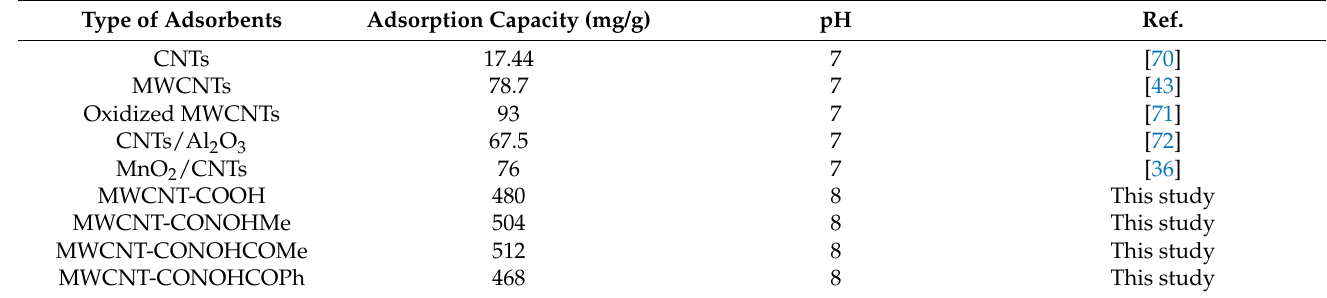
Table 7. Some CNT adsorbent capacities have been reported for lead ion